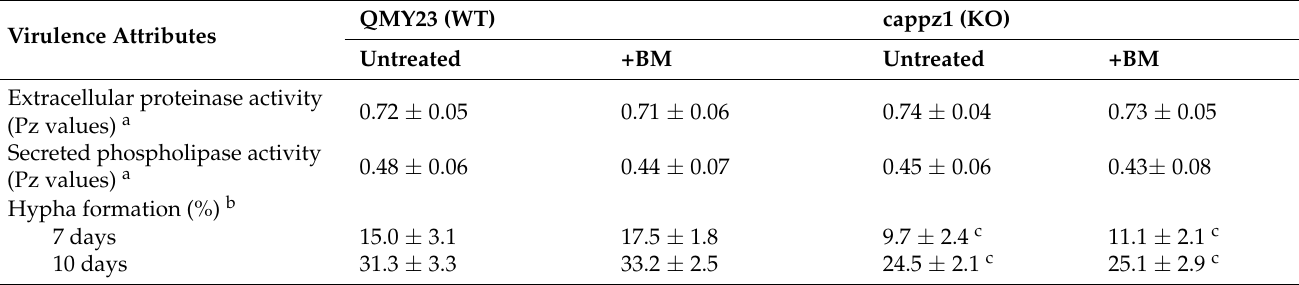
Table 3. Effect of betamethasone (BM) on the virulence attributes of C. albicans